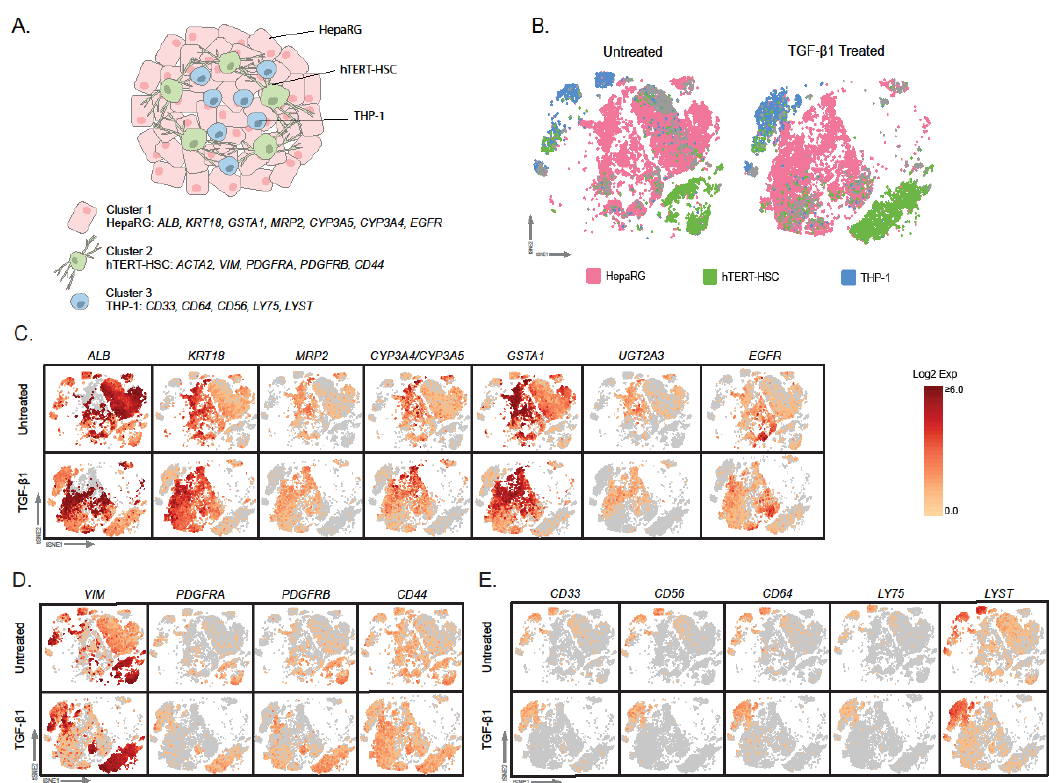
Figure 5. Expression of cell-specific markers in the identified cell clusters. Pre-processed single cell sequencing data was analysed using CellLoupe. Schematic representation of the composition of multicellular MTs and known cell type-specific markers ( A ). Supervised clustering based on the cell type-specific markers in untreated and TGF- β 1-treated samples led to the identification of HepaRG (pink), hTERT-HSC (green) and THP-1 (blue) and cells that did not cluster based on the chosen genes (grey) more detail can be found in methods section “Gene-based identification of specific cell clusters“ ( B ). Examples of marker expression for HepaRG ( C ), hTERT-HSC ( D ) and THP-1 ( E ) in untreated and TGF- β 1-treated samples. As ACTA2 is also a fibrotic marker it is shown in Figure 7. Data are expressed as log2 expression (selected markers shown in tSNE plots).